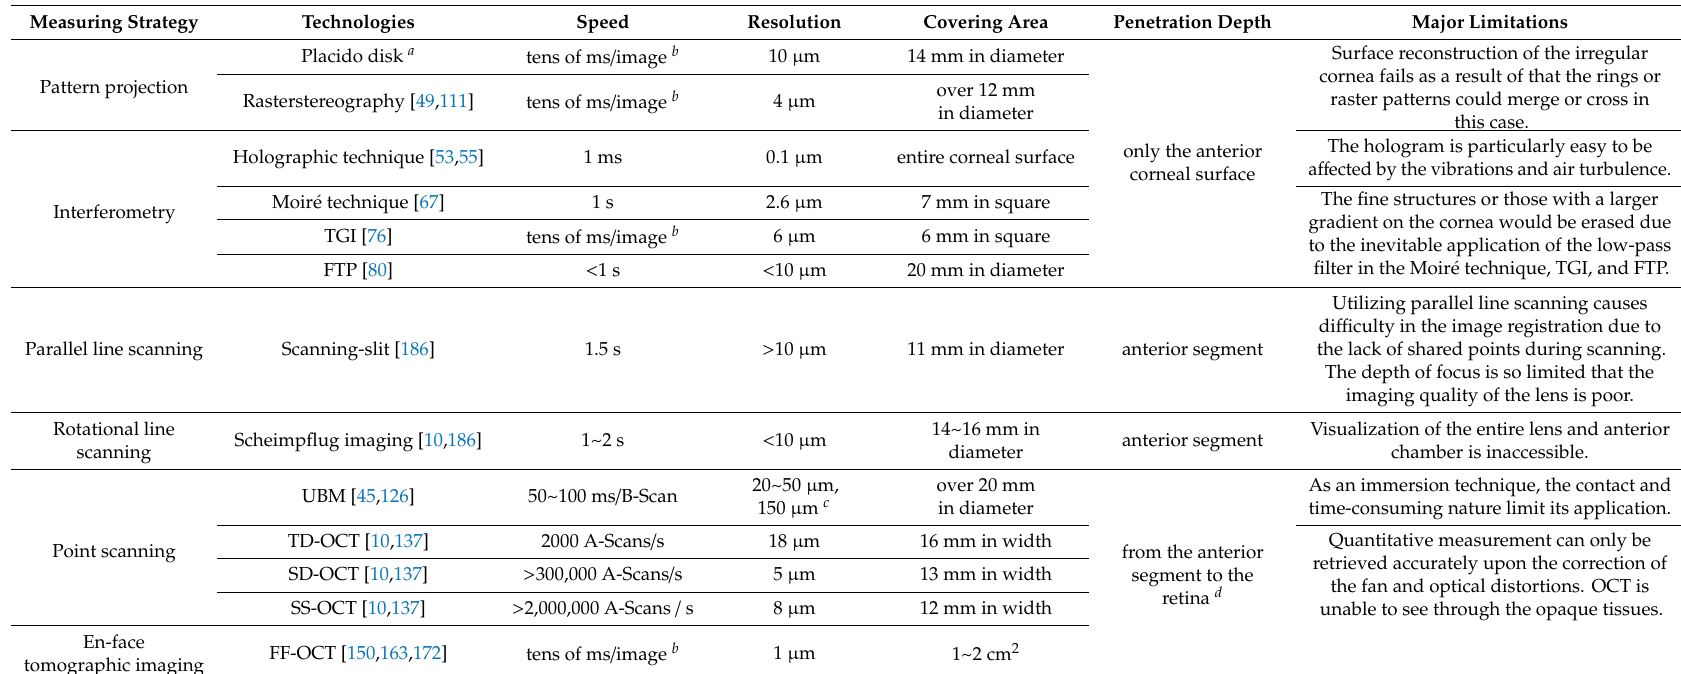
Table 2. The comparison of the mentioned measuring